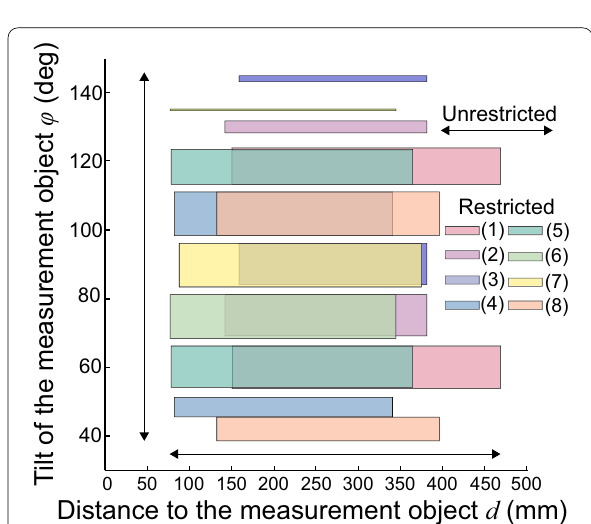
Fig. 14 Result of HILS on circular operation